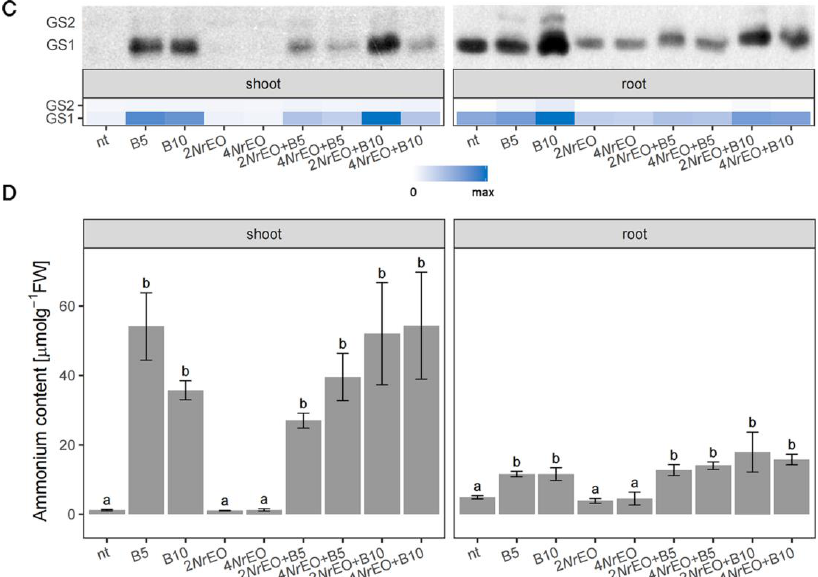
Figure 2. Dose-dependent effects of BASTA (B5 and B10, with 5 and 10 mg L − 1 , respectively), N. rtanjensis essential oil (2 Nr EO and 4 Nr EO with 2% and 4% Nr EO, respectively), and their mixtures ( Nr EO + BASTA) on in vitro grown Arabidopsis plants. ( A ) Total GS activity in shoots and roots. Values are presented as means ± SD, and significant differences according to Tukey’s HSD post-hoc test at p < 0.05 are indicated with a compact letter display. ( B ) Distribution of GS isoforms activity from shoot and root extracts, stained after native PAGE (50 µ g total protein per well). Arrows indicate a mobility shift of GS bands. ( C ) Immunoblots conducted with specific GS antibodies. Heat-maps show relative abundances of GS proteins. Maximal values on the color scales represent maximal values recorded for each immuno blot, independently. ( D ) Ammonium content in shoots and roots. Values are presented as means ± SD. Significant differences according to Tukey’s HSD post-hoc test at p < 0.05 are indicated with a compact letter